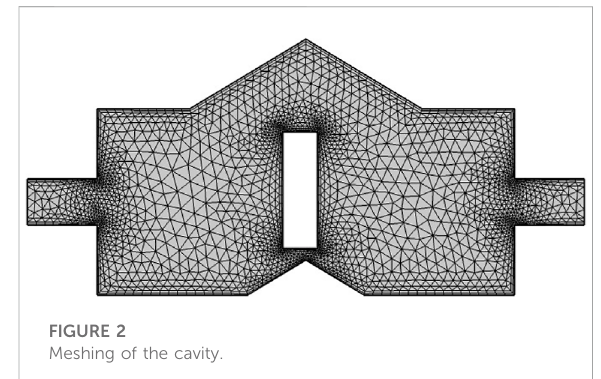
FIGURE 2 Meshing of the